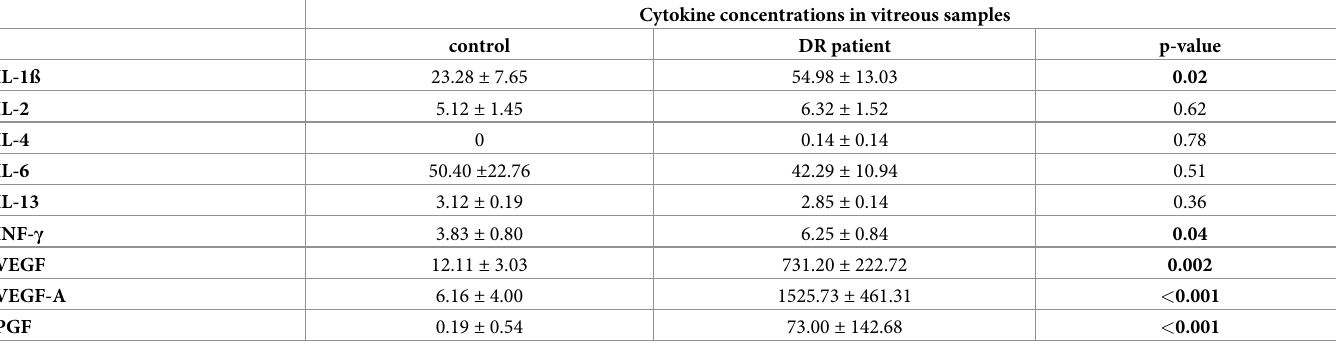
Table 3. Cytokine concentration (pg/ml) in vitreous samples of control and diabetic retinopathy (DR) patients measured via ELISA. Significant p-values are in bold.